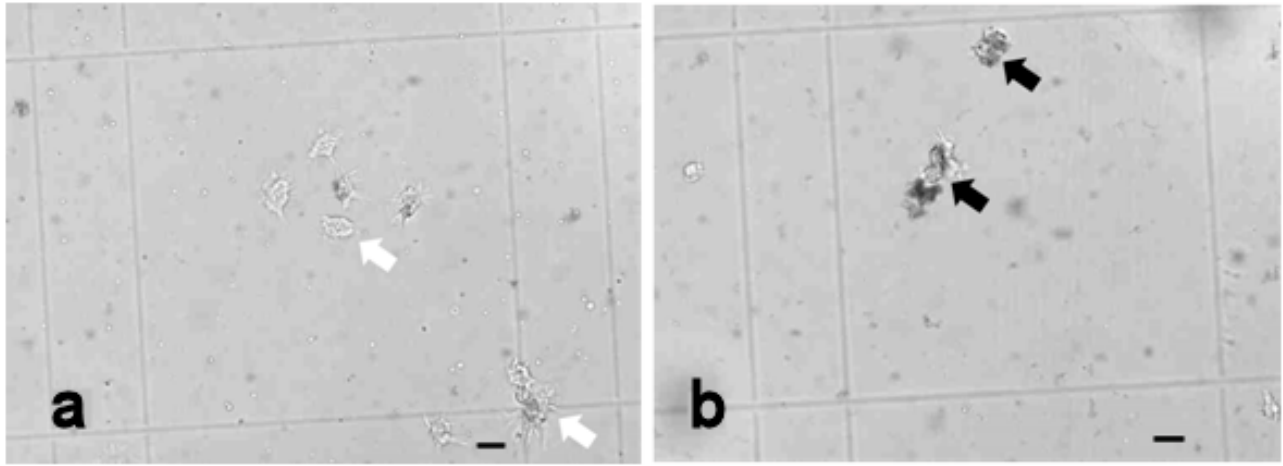
Figure 5. ( a ) normal haemocytes (white arrow) from control mussels and ( b ) malformed haemocytes (black arrow) from mussels exposed to 50 μ m PMMA particles with vacuolisation and deformed nuclei. Scale bar 10 μ m.